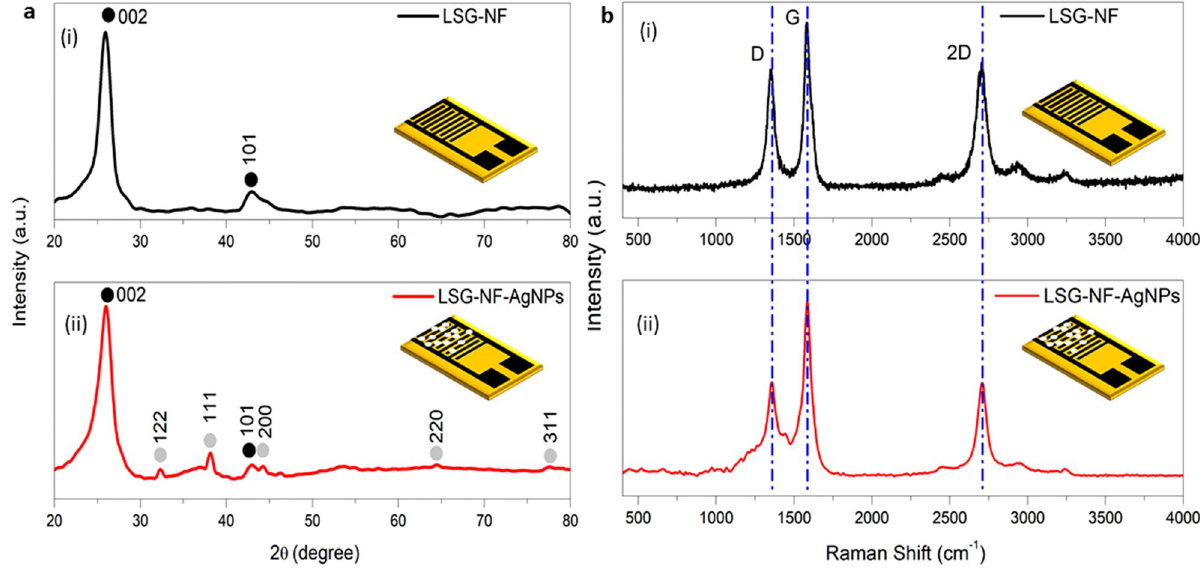
Figure 3. ( a ) X-ray diffraction and ( b ) Raman spectra of LSG-NF, (i) before and (ii) after adding